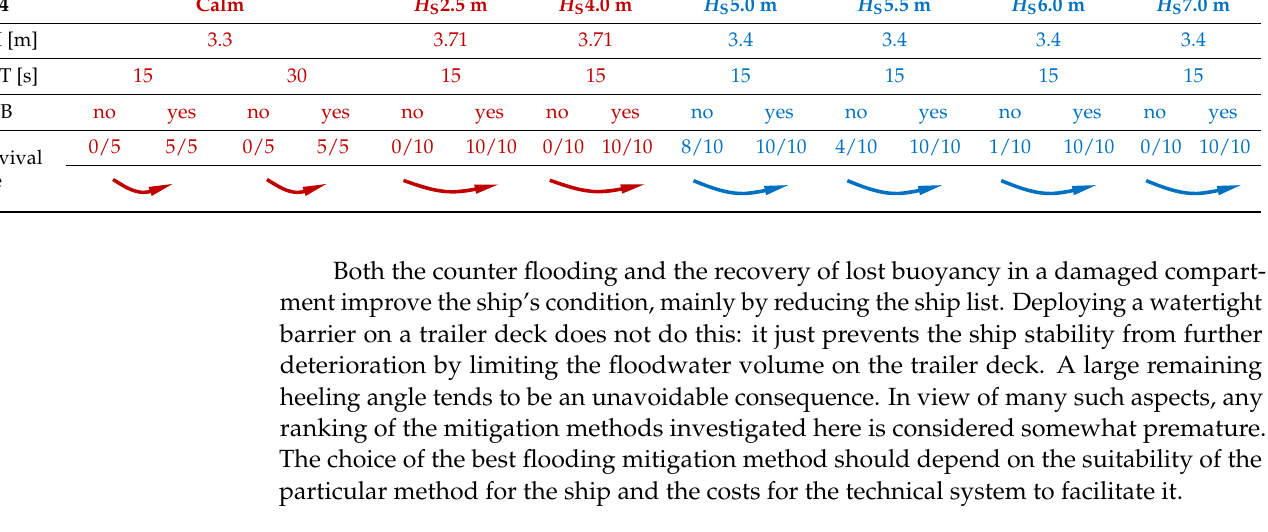
Table 7. Numerical (blue) and experimental (red) mitigation results with deployment of a water ‐ tight barrier in Damage Case 4, T p = 10.0 s.